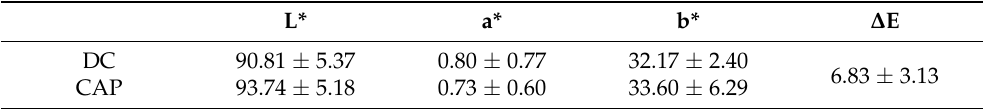
DC, dentin color; CAP, CAP system